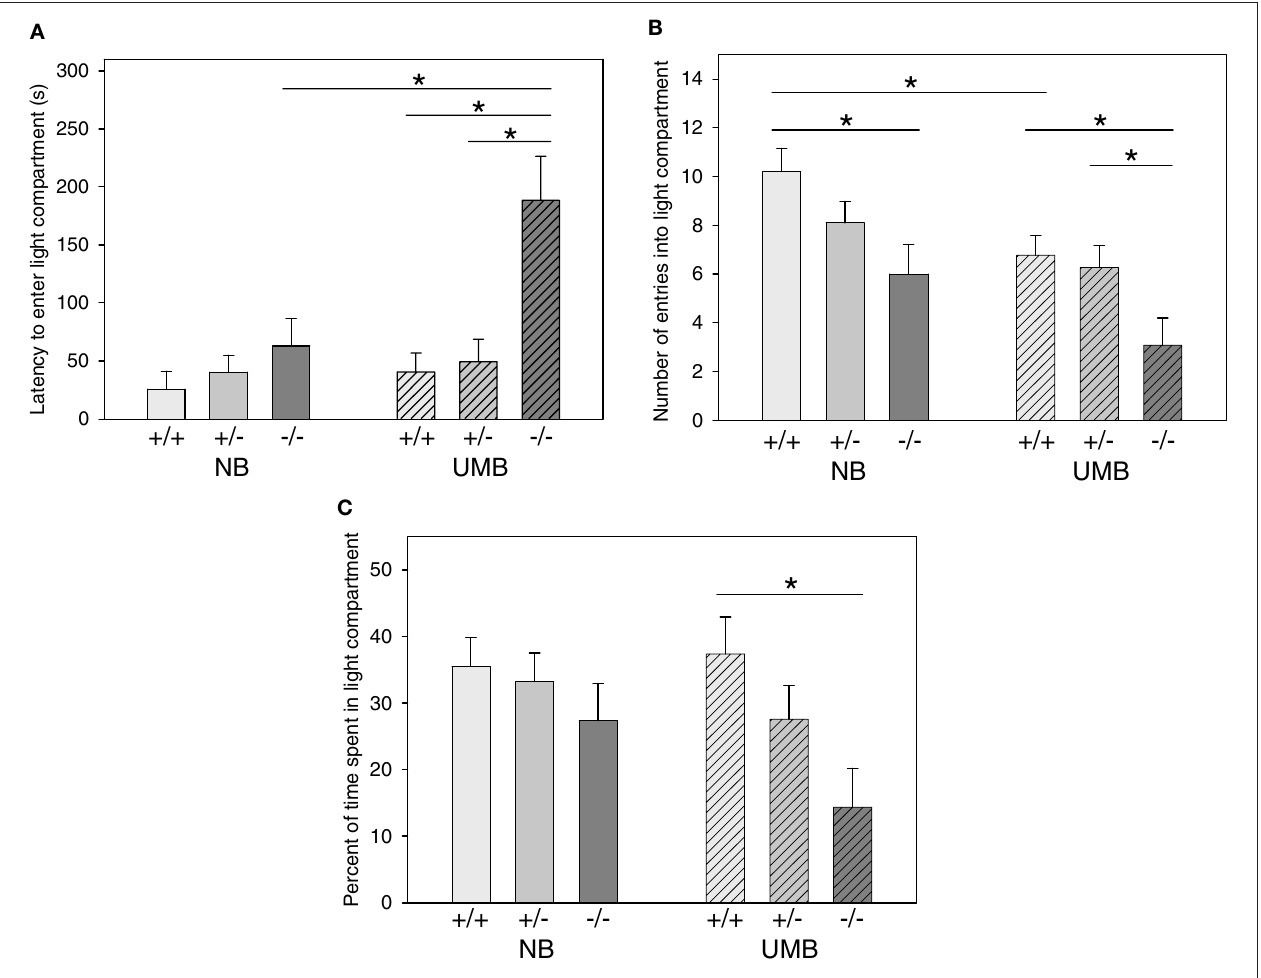
(7 + / + , 5 + / − , 7 − / − mice). (A) Latency to enter light compartment. There was a signifi cant main effect of genotype ( P = 0.009) and treatment ( P = 0.017). (B) Number of entries into light compartment. There was a signifi cant main effect of genotype ( P = 0.004) and treatment ( P = 0.002). (C) Percentage of time spent in light compartment. There was a signifi cant main effect of genotype ( P =